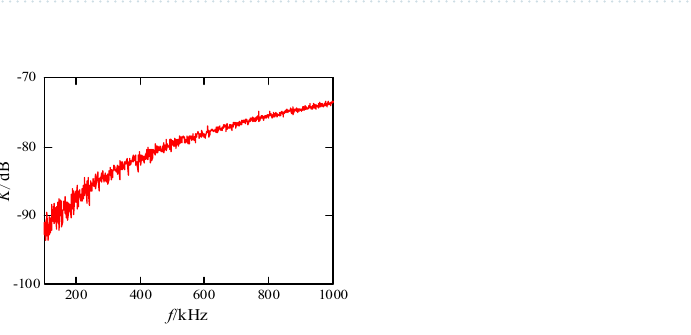
Figure 27. Mutual inductance measurement: ( a ) measurement approach of mutual inductance; ( b ) object diagram.